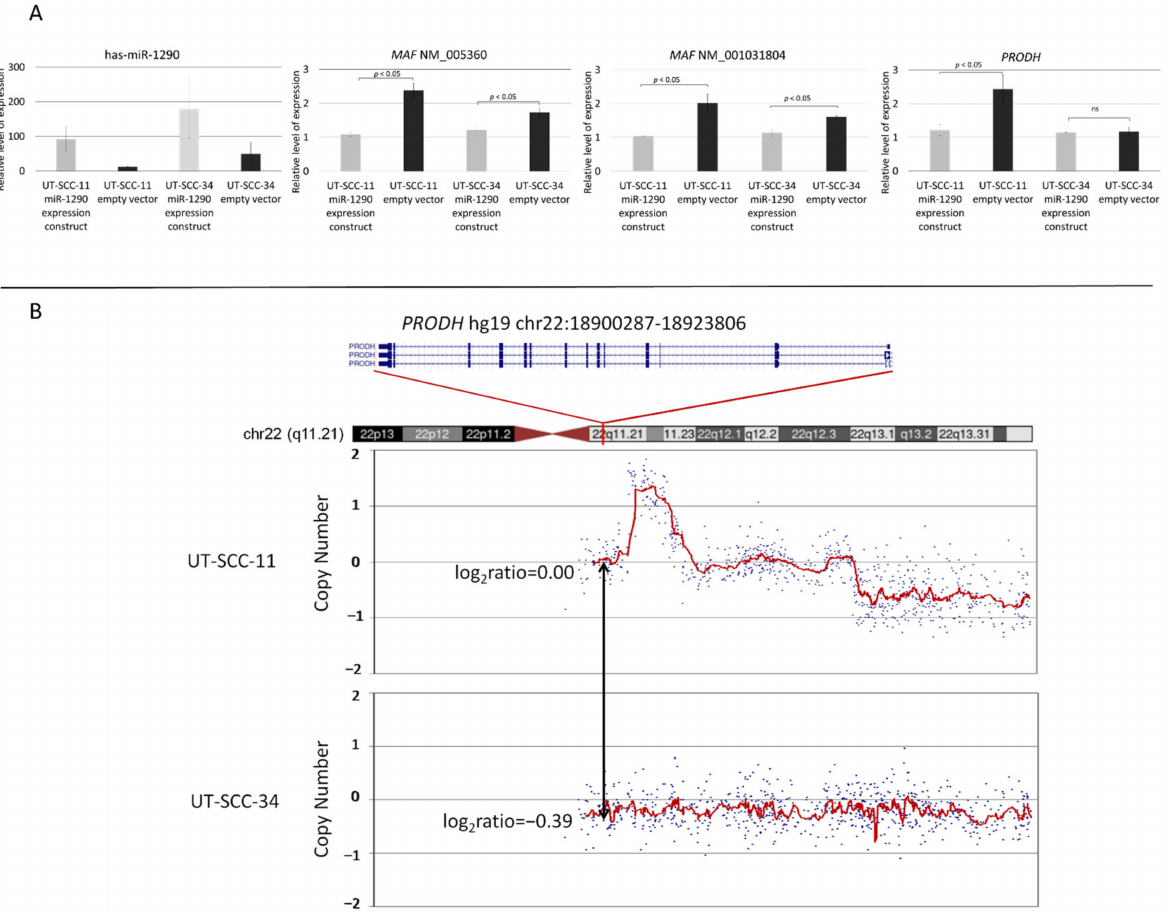
Figure 4. Expression level of MAF NM_005360, MAF NM_001031804 and PRODH genes in LSCC cell lines after transduction by miR-1290 expression vector or empty vector ( A ). Copy-number plots based on array CGH data for chromosome 22 in UT-SCC-11 and UT-SCC-34 cell lines [17,18]. The red line on the plots represents the mean copy number. The black arrow points to PRODH -associated array tag ( B ). ns: not